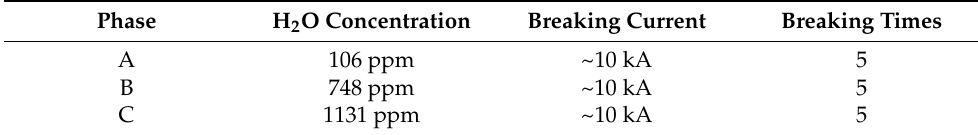
Table 1. Setting of breaking experiment with different H 2 O concentration. Table 2. Setting of breaking experiment with different O 2